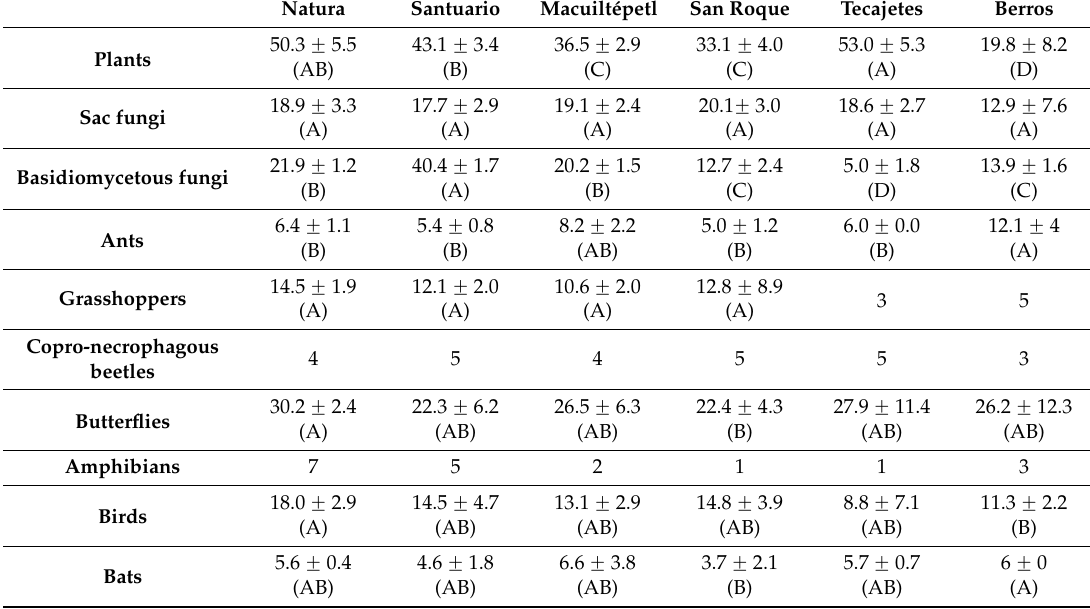
Letters below values for each greenspace indicate statistically significant